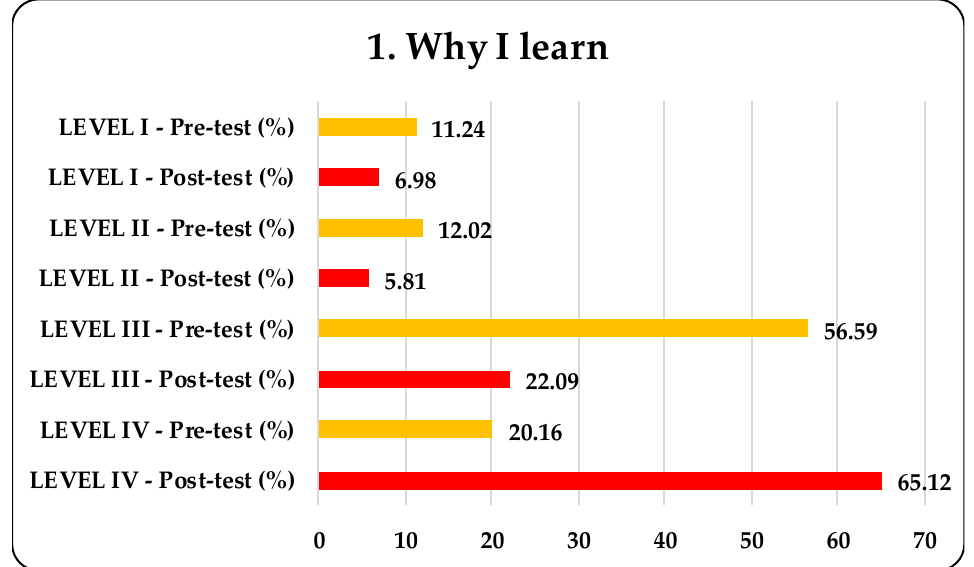
Figure 6. Levels of achievement of the first dimension: Why I learn.